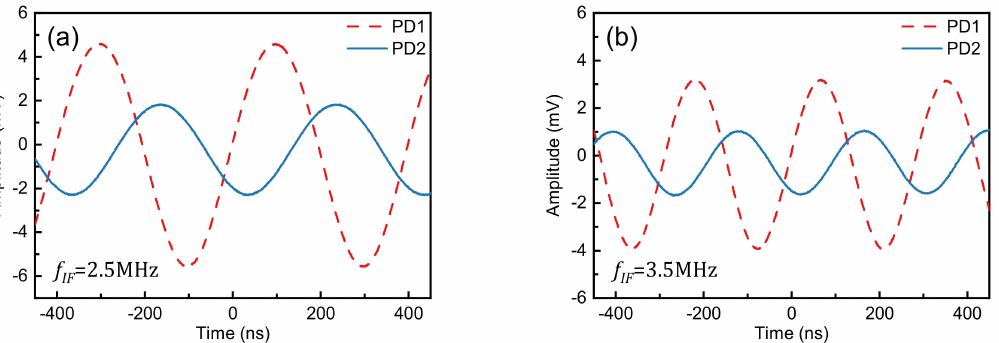
Figure 5. Electrical waveforms of down-converted IF signal when the DFS is ( a ) +0.5 MHz and ( b ) − 0.5 MHz, respectively.